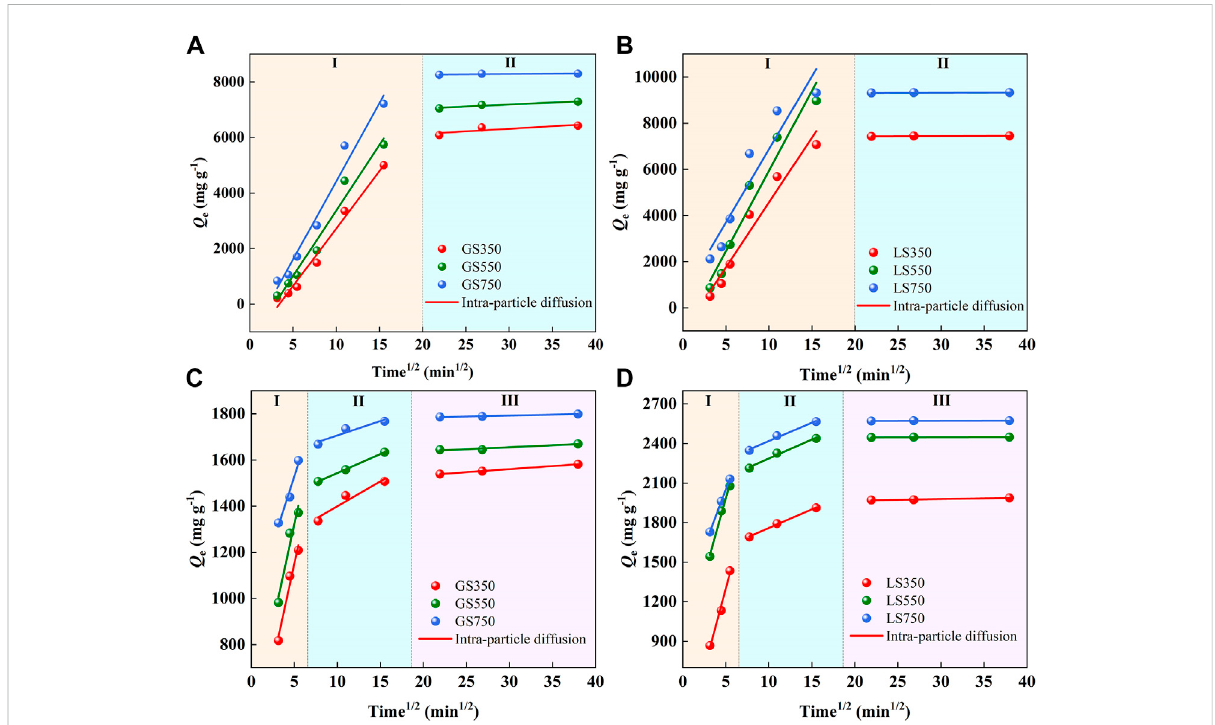
The intra-particle diffusion models of MG (a, b) and ST (c, d) sorption onto GSBC and LSBC. I, II, and III represent the different stages of intra- particle diffusion, respectively. [Conditions] For MG and ST, initial pH of 8 and 4, respectively, initial concentration of 3,500 mg L − 1 dye, 15 mg biochar, 10 – 1,440